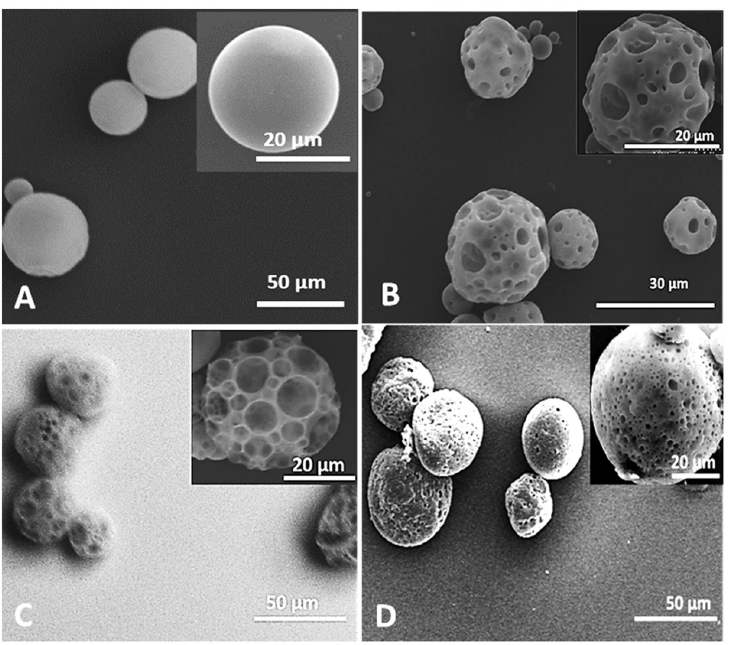
Fig 1. Morphology of porous PLGA MPs. SEM images of (A) non-porous PLGA MPs and porous MPs prepared using (B) gelatin, (C) SBC, and (D) PMPs as porogens. The spherical morphology and porous nature of PLGA-Gelatin, PLGA-SBC, and PLGA-PMPs can be clearly visualized.